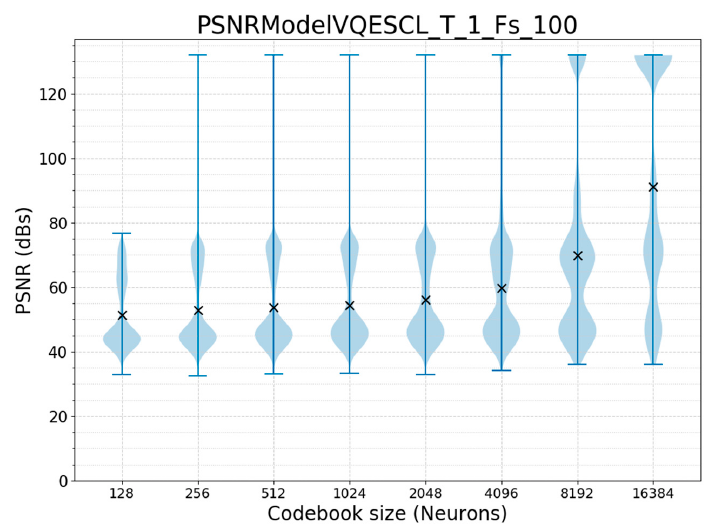
Figure 9. Peak signal-to-noise ratio (PSNR) distribution and mean value (x) vs. codebook size N for the error sensitive competitive learning (ESCL) model (F = 100 Hz, T = 1 s).